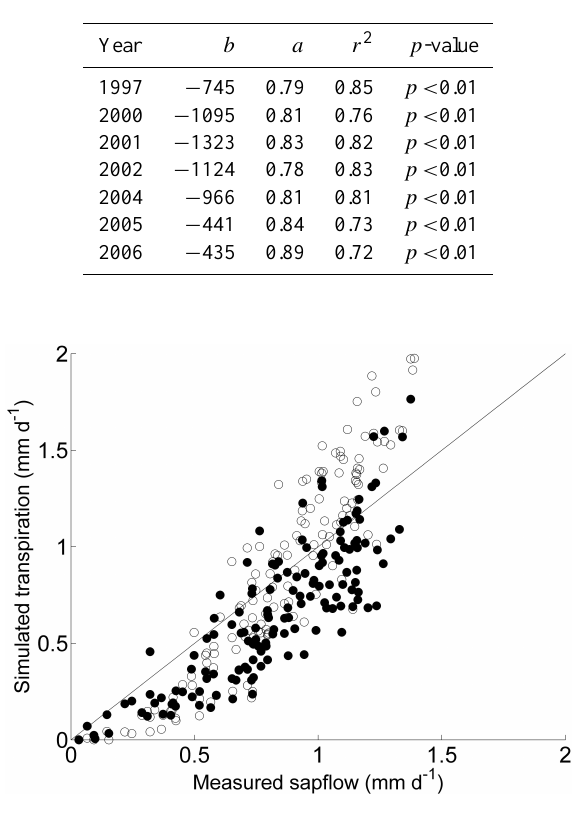
Fig. 3. The relationship between canopy transpiration (mmd − 1 ) simulated by (SECRETS ( • ) and ORCHIDEE ( ◦ ) (ordinate) and up- scaled estimates from sap flow (abscissa) measured over a period of 120days in 2001. The solid line depicts the 1:1 relationship.